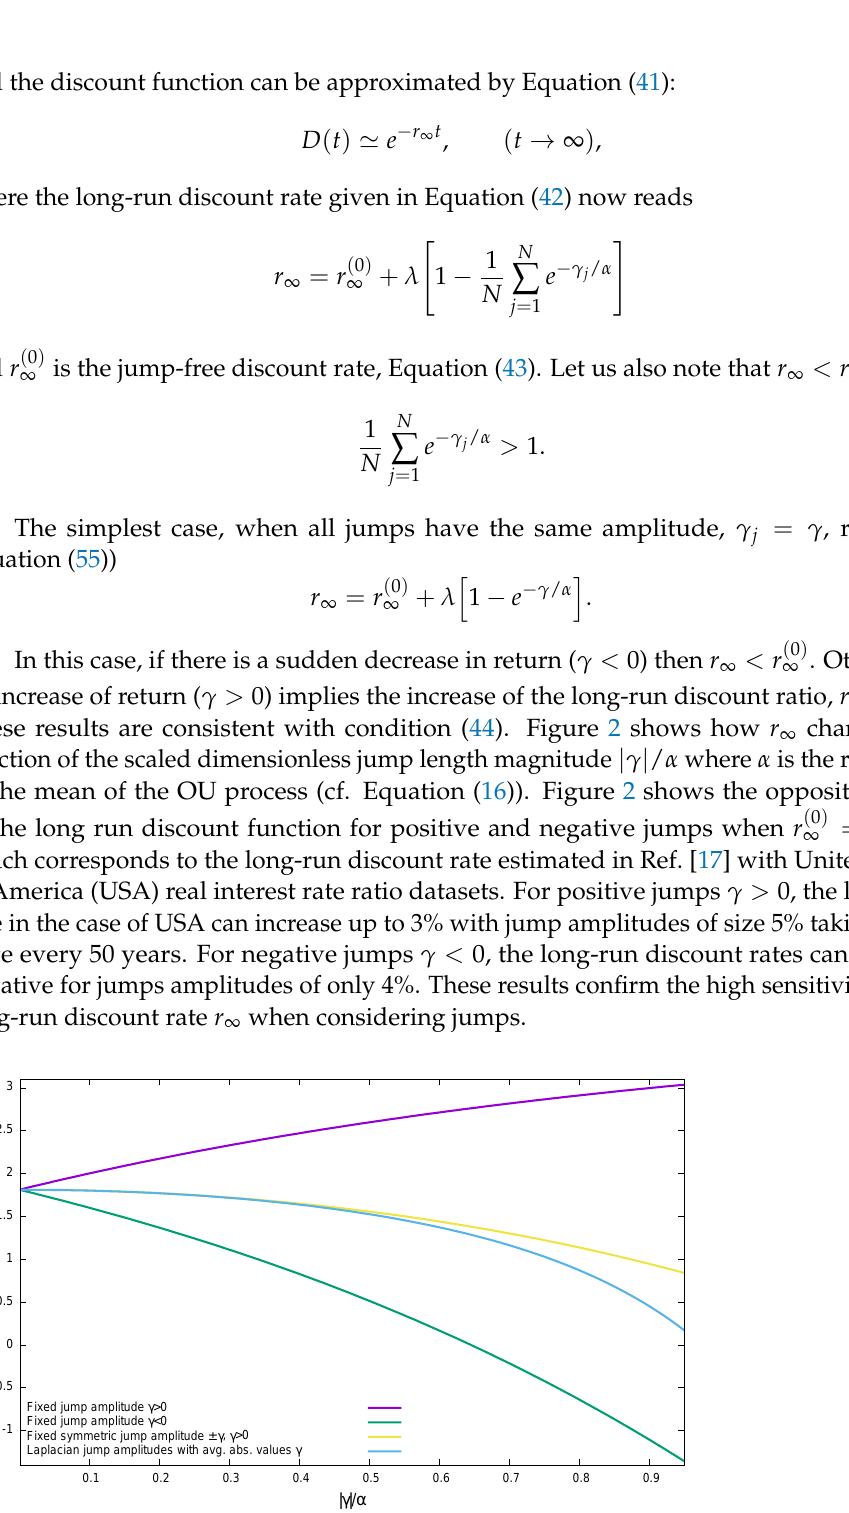
Figure 2. The long-run discount rate r ∞ as a function of the the scaled jump size ( | γ | / α ) for jumps with fixed and bounded amplitudes ( γ > 0 and γ < 0, cf. Equation (57)), with two fixed and bounded symmetric jumps ± γ (cf. Equation (58)) and for Laplacian jumps with average absolute value equals to γ (cf. Equation (68)). In all cases, jumps frequency λ is 1/50 years and r